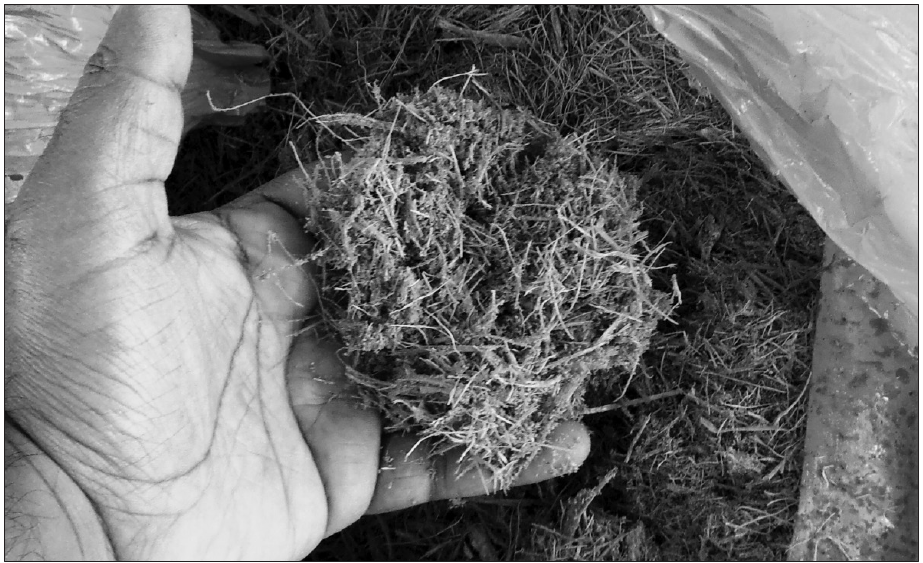
Figure 1: Sugarcane